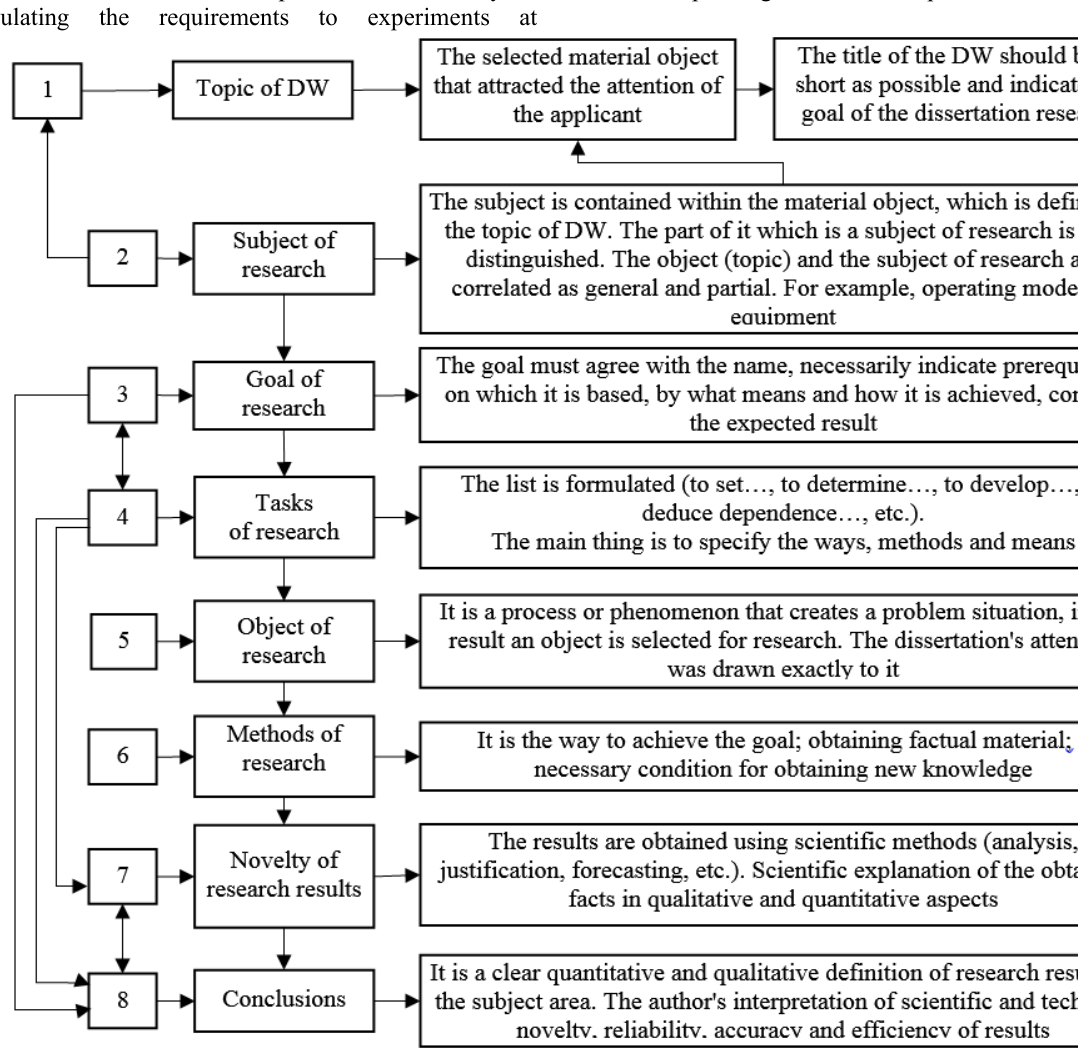
Figure 1. The structure and relationship of the main components of the problem statement and evaluation of research